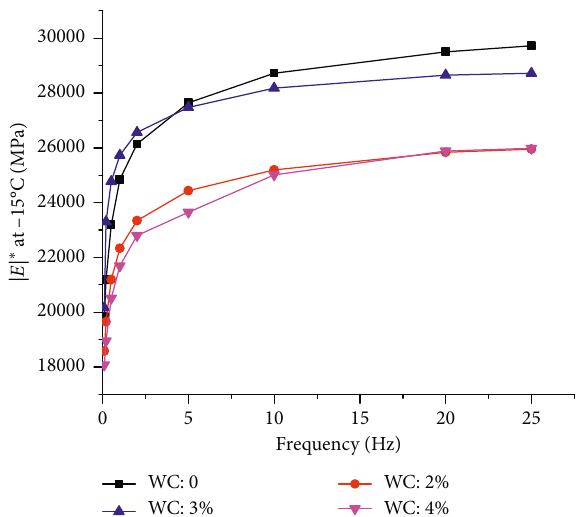
Figure 9: 70#AC-20-type normal-temperature dynamic modulus.